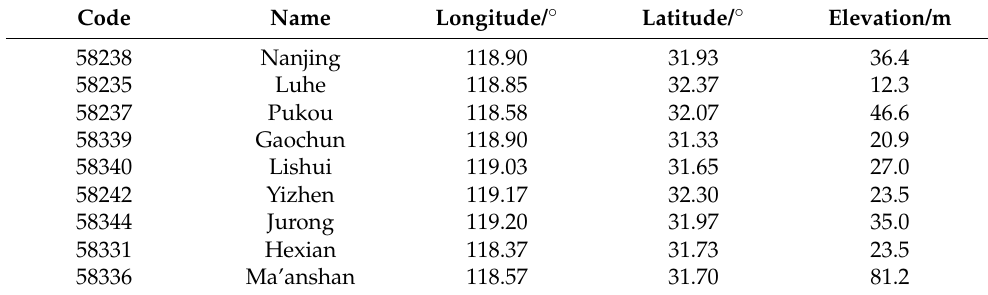
Table 2. Weather station